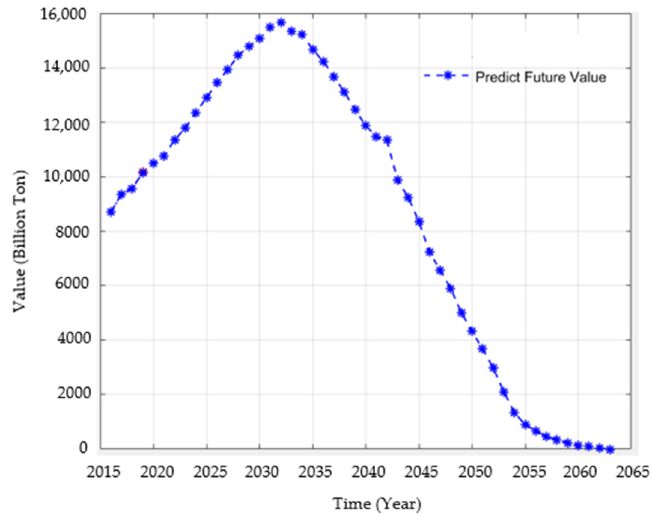
Figure 4. Forecast data on CO 2 emissions from 2020 to 2060 by BP neural network model.